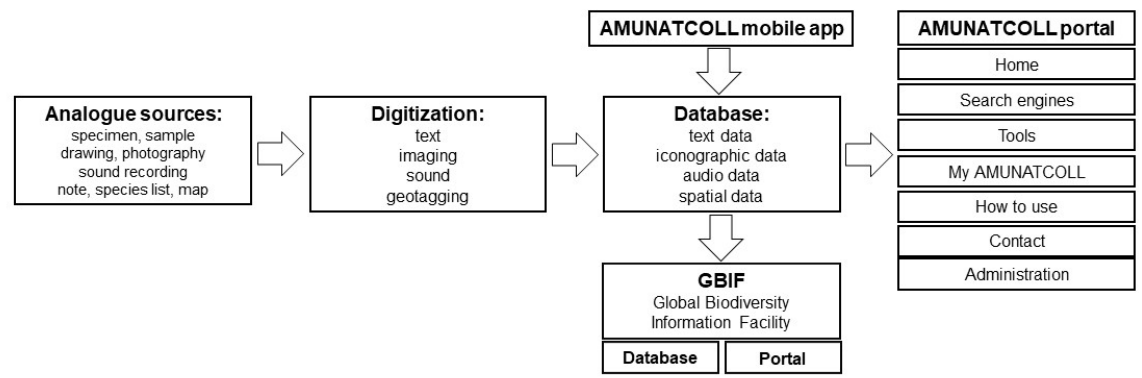
Figure 3. The process of digitizing and sharing biodiversity data in the AMUNATCOLL IT system.